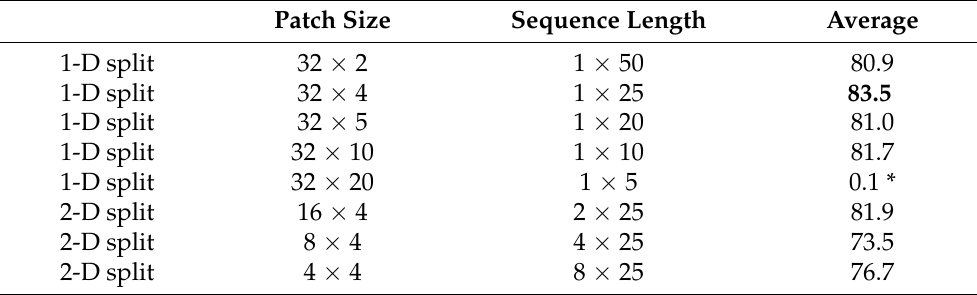
Table 3. Performance comparison with different patch size. ’Average’ denotes the average accuracy of seven standard benchmarks. * indicates that the model did not converge, possibly because sequence length is too short to